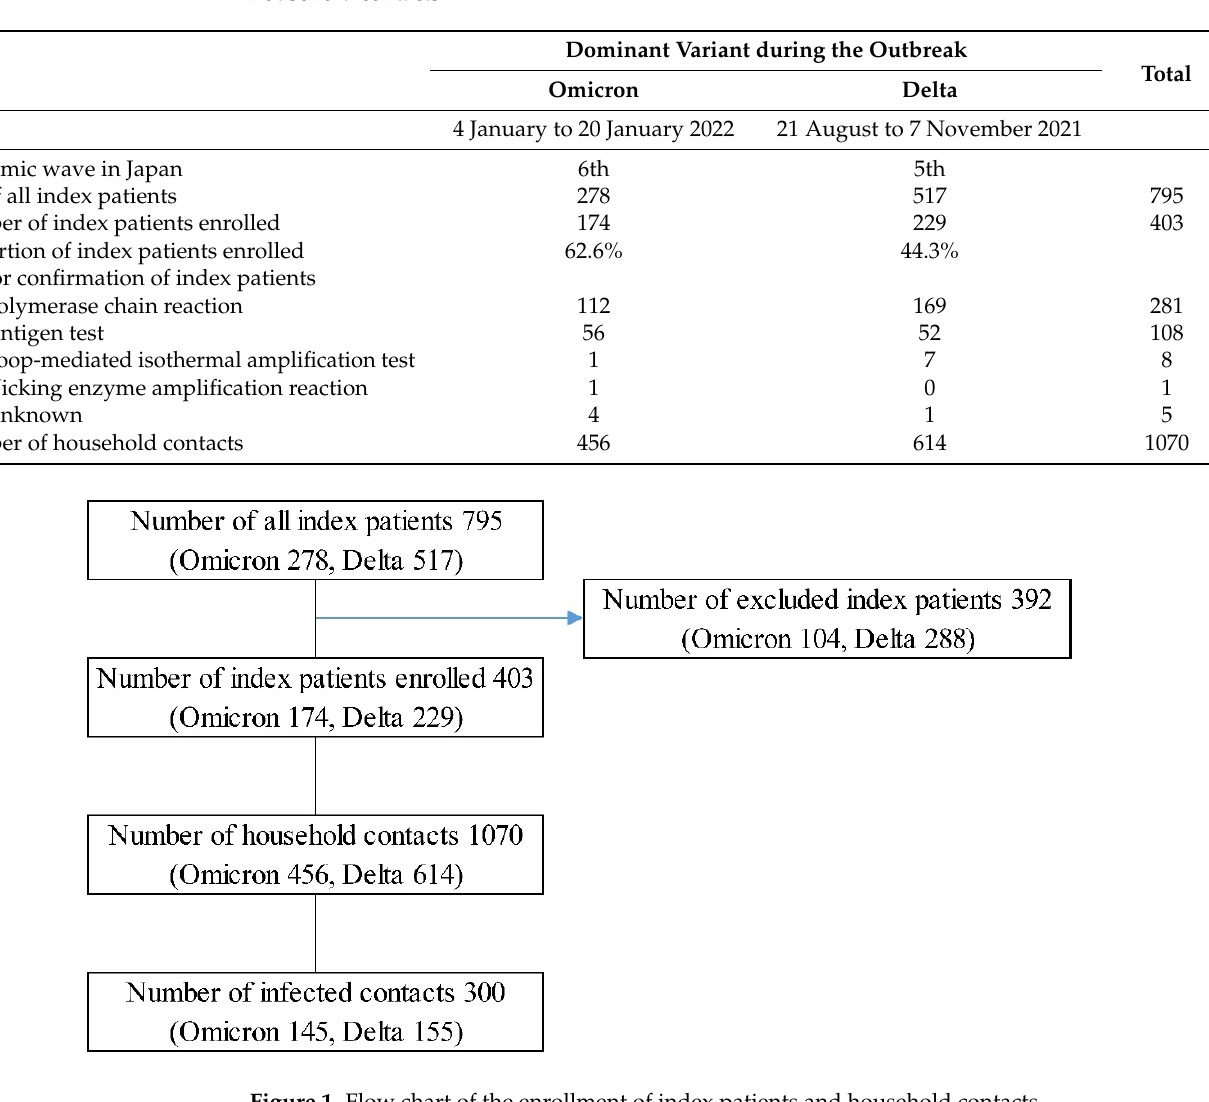
Table 1. Study period, enrollment of index cases, tests for case confirmation, and the number of household contacts.